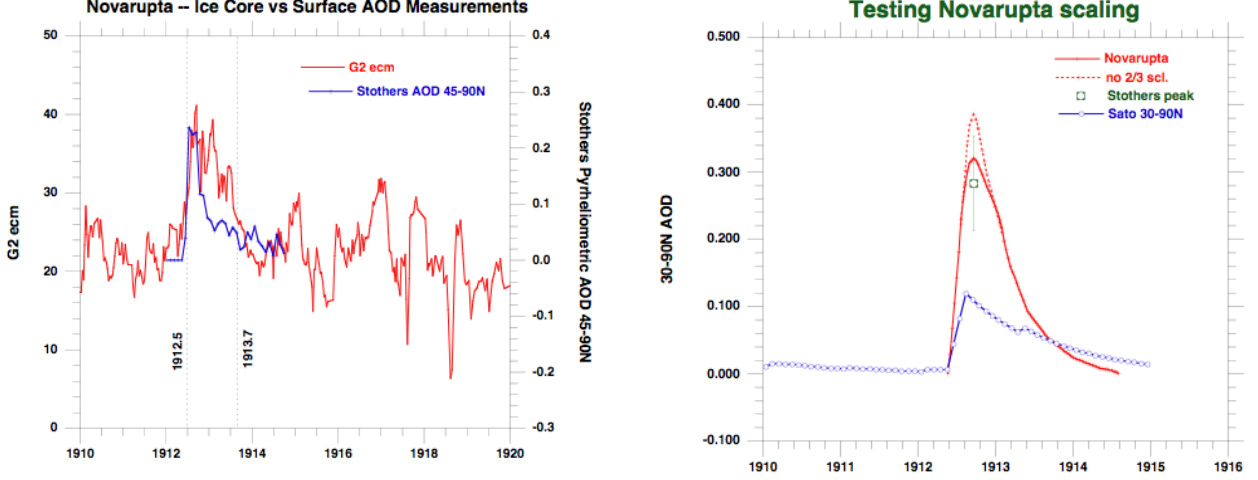
Figure 5. Independent test of ice core AOD calibration, and 2 / 3 power scaling rule, against Stother’s (1996) reanalysis of 1912 No- varupta eruption. For reference, the Sato et al. (1993) values are also